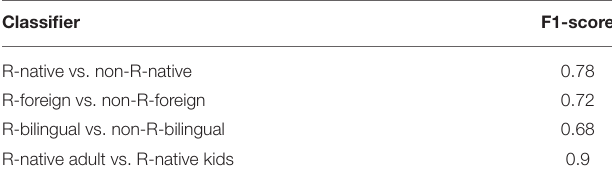
TABLE 2 | F1-scores in binary feature based classifiers.